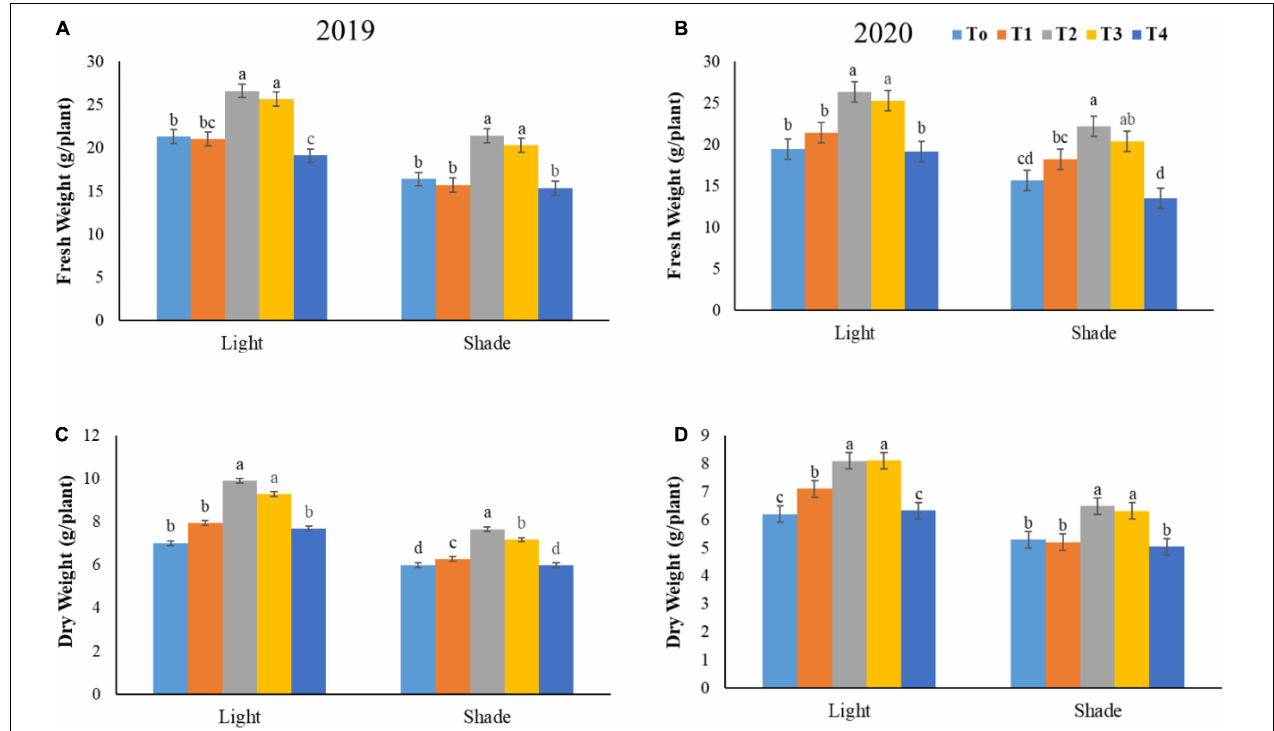
FIGURE 3 | Effect of various NH 4 + /NO 3 - ratios on fresh weight (A,B) , and dry weight (C,D) under light and shade. Different treatment levels T0, T1, T2, T3, and T4 characterize the ratios of NH 4 + /NO 3 - 0/0, 0/100, 25/75, 50/50, and 75/25, respectively. All of the results are the mean of three replications. The bars represent the ± SD (standard deviation). A significant difference (* p < 0.05) between treatments is shown by different lowercase letters above